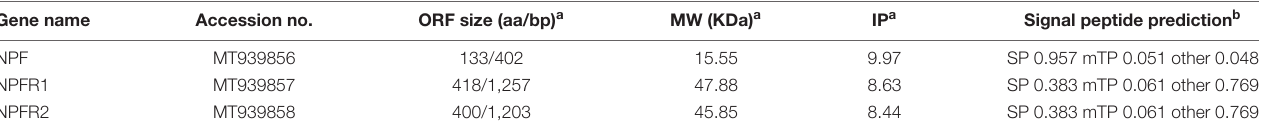
TABLE 1 | Physicochemical properties and cellular localization of D. armandi NPF and NPFR